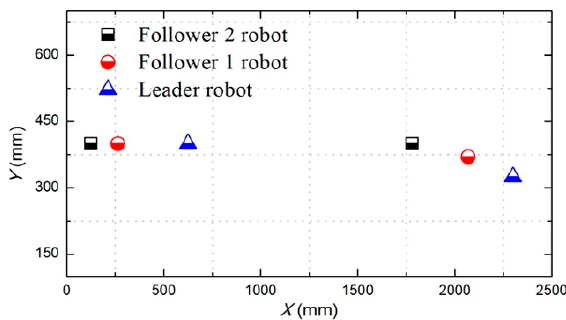
Figure 16. Robots formation experiment with a longitudinal queue.